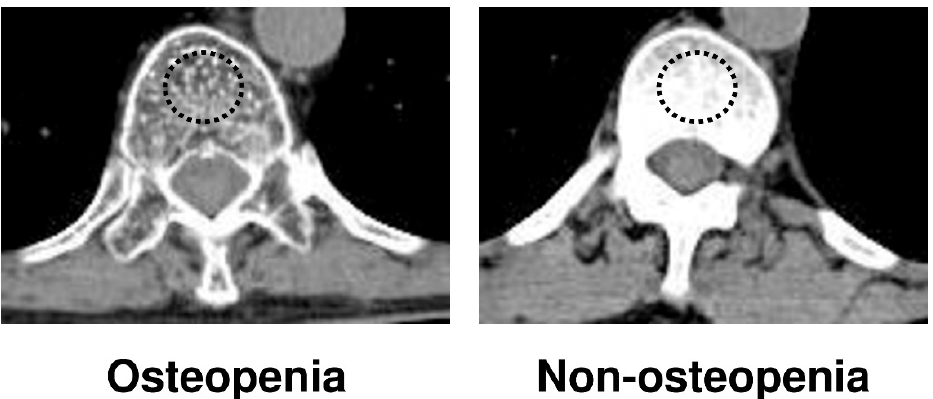
Figure 1. Measurement of bone mineral density on trabecular bone with calculation of the average pixel density within a circle in the mid-vertebral core at the 11th thoracic vertebral (T11)